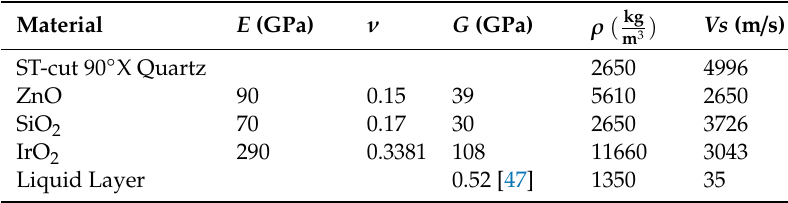
Table 1. Properties for various materials that are used in the model. Material